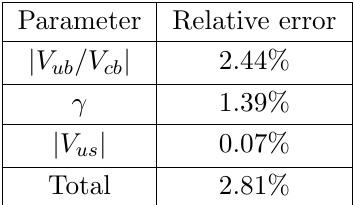
Table 11 . Error budget for the observable sin(2 (cid:12) s